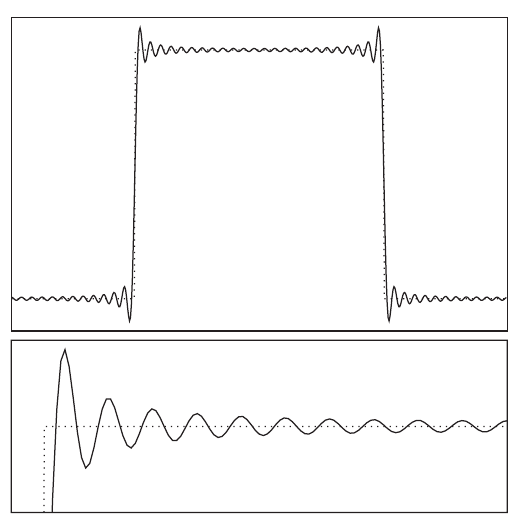
Figure 1: (Top) One-dimensional profile of a rectangle recon- structed by Fourier transformation from 96 Fourier samples (solid line) in comparison to the true function (dotted). While the true function is piecewise constant, the Fourier reconstruction exhibits severe ringing artifacts due to truncation of the Fourier coe ffi cients, which causes an increased total variation (TV) value. (Bottom) Magnified